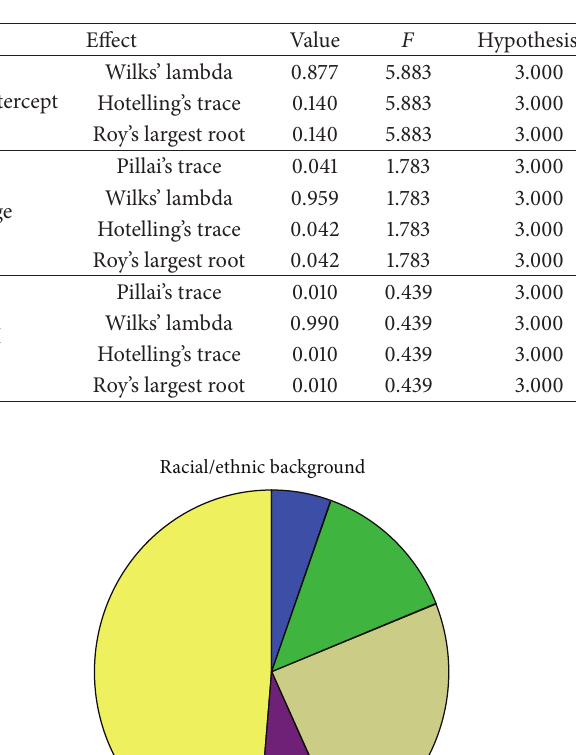
Table 4: MANCOVA to verify aim (3).